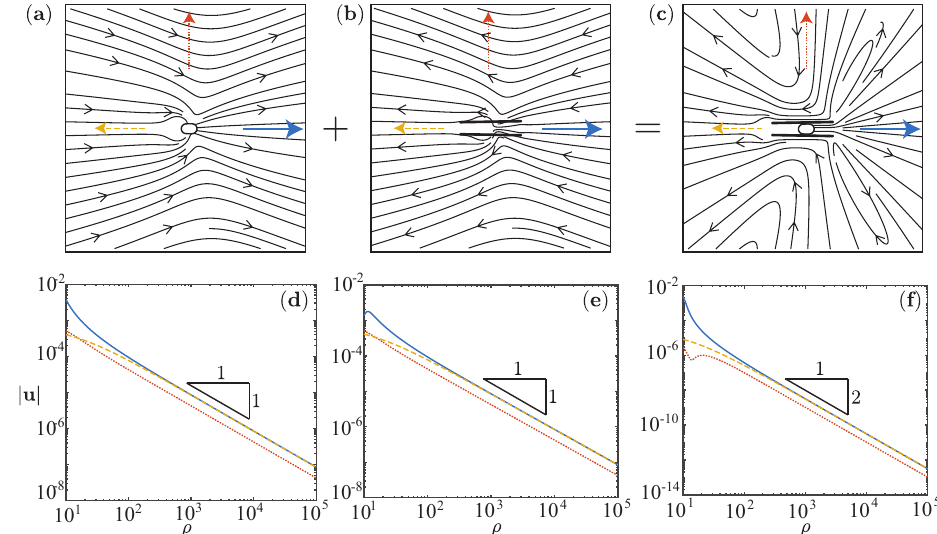
Figure 3. Far field streamlines and velocity magnitude at t = 1000 for Ca = 0.01 and θ = 1 ◦ . ( a – c ) Cone, bubble and cone-bubble induced velocity field respectively; ( d – f ) decay of velocity in three directions, in the rear (yellow) and forward (blue) direction of the cone, and in the radial (orange)